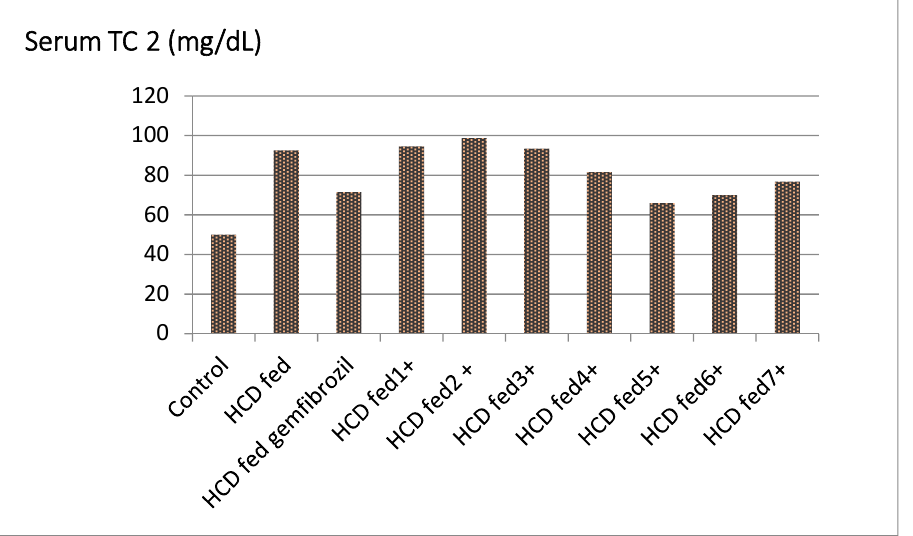
Figure 2. Effect of the tested compounds and gemfibrozil on serum TG of hyperlipidemic rats. Compounds 5 and 6 significantly increased HDL levels in hyperlipidemic rats’ serum, ranging from 33.47% to 41.13% higher than the control, while compounds 2 , 4 , and 7